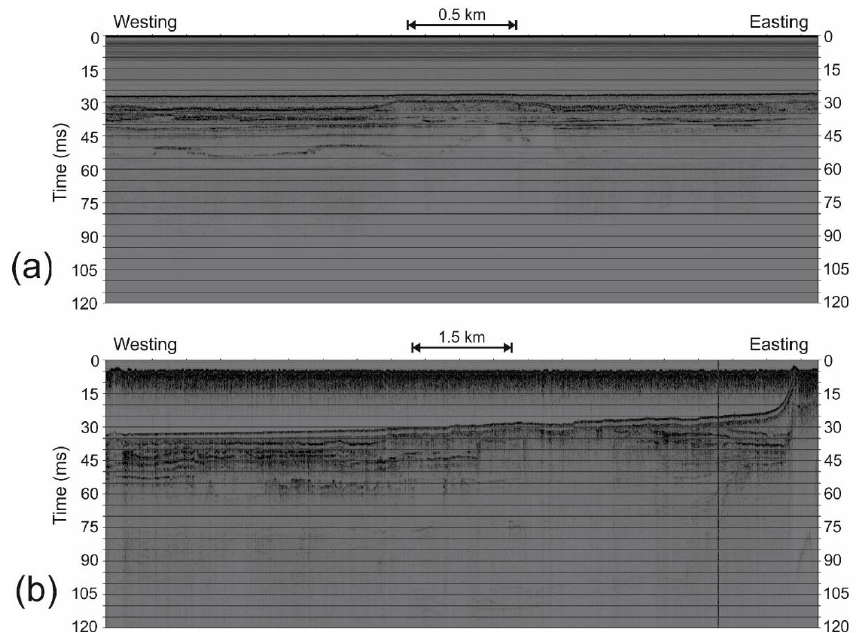
Figure 10. Two intersecting profiles acquired at the Gulf of Trieste (Adriatic Sea) using a Chirp system ( a ) and a Boomer system ( b ).